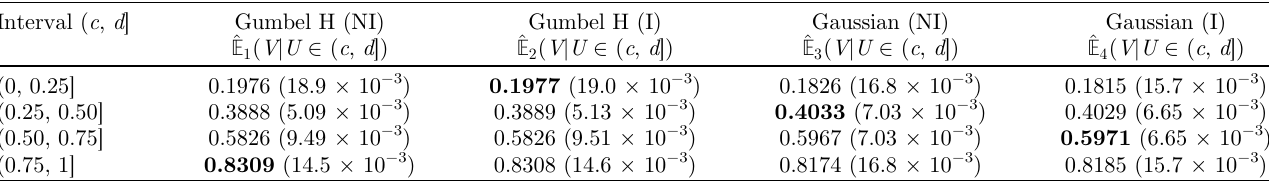
Table 9. E i , i = 1, 2 computed using Gumbel – Hougaard copula (Eq. (11)), E i , i = 3, 4 computed using Gaussian copula (Eq. (10)), i = 1, 3 from Non Informative settings, i = 2, 4 from Informative settings. In brackets, the standard deviation of the expected values. In bold, the highest mean expected values per line.